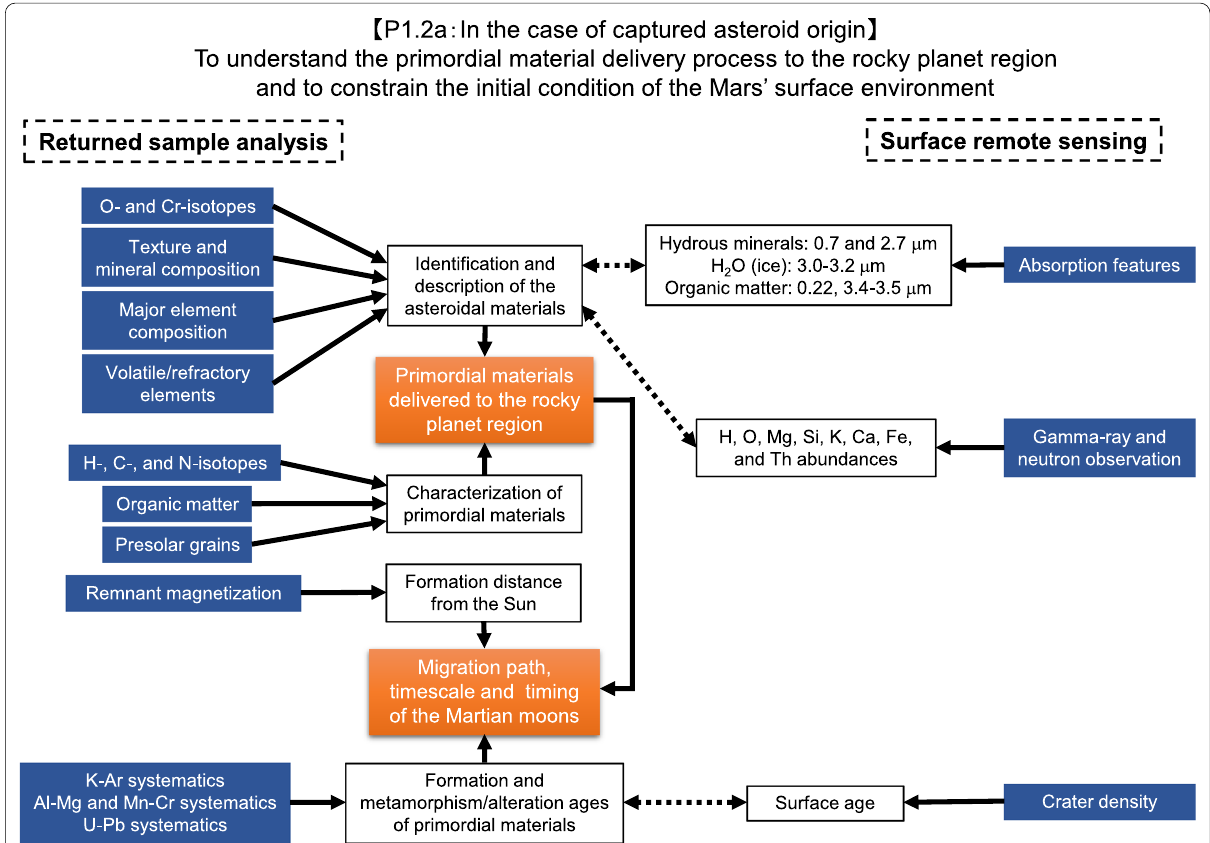
Fig. 2 Flowchart of sample analyses together with remote sensing observations to characterize the Phobos building blocks in the case of the captured asteroid origin (objective 1.2a in Table